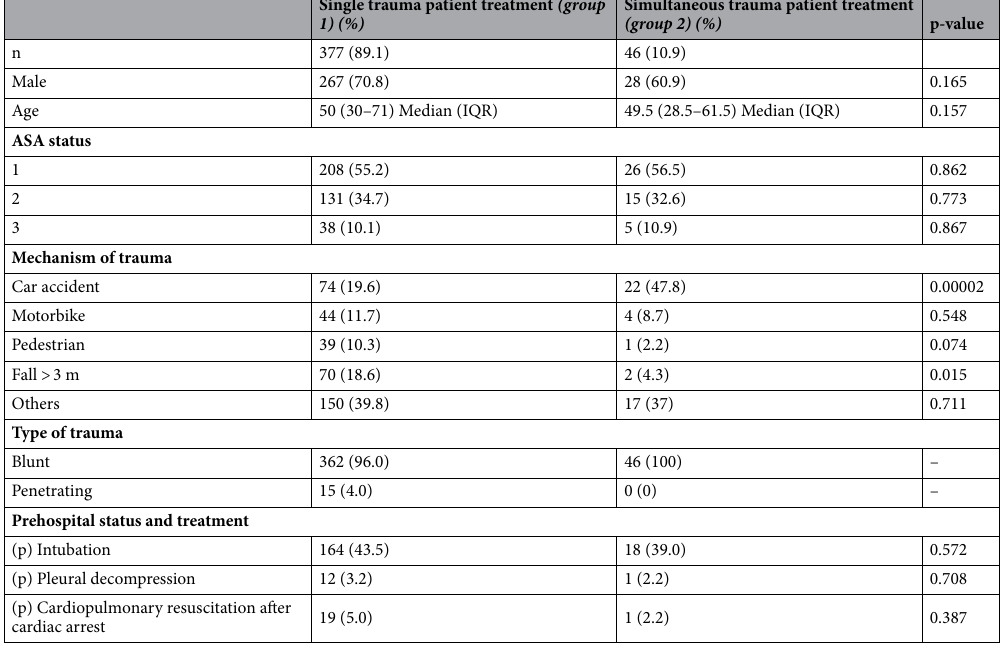
Table 2. Patients’ and prehospital trauma characteristics (Age = Median (IQR); p = prehospital).